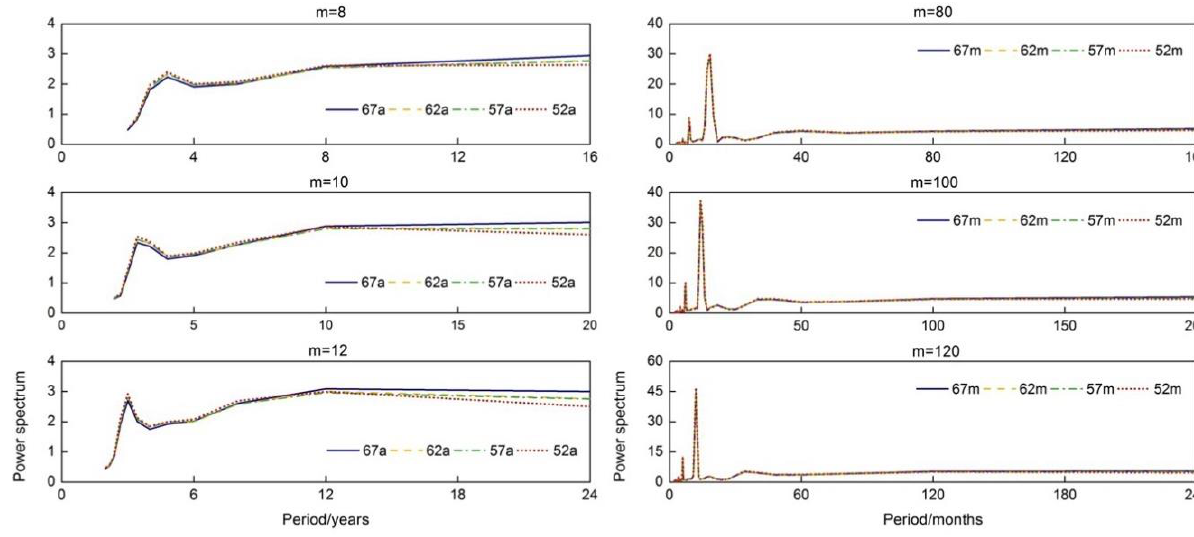
Figure 3. Periodogram of LHS.